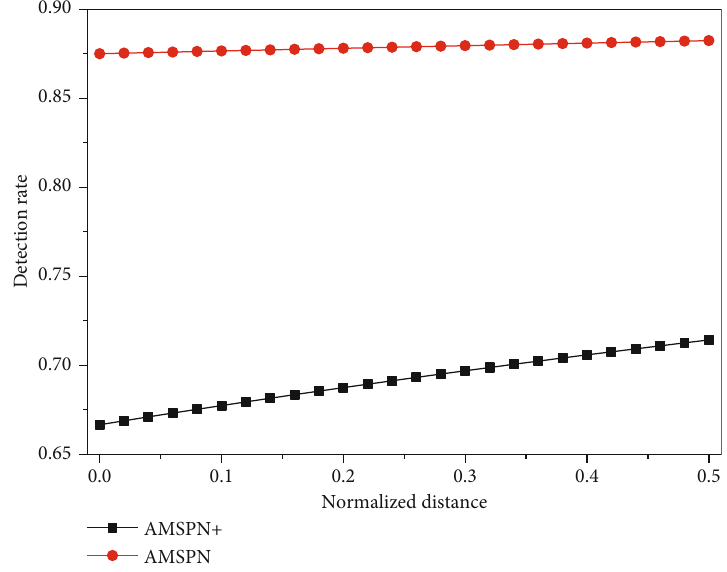
Figure 7: Average PCKh curves of the 3D di ff usion model and the conventional model on the MPII